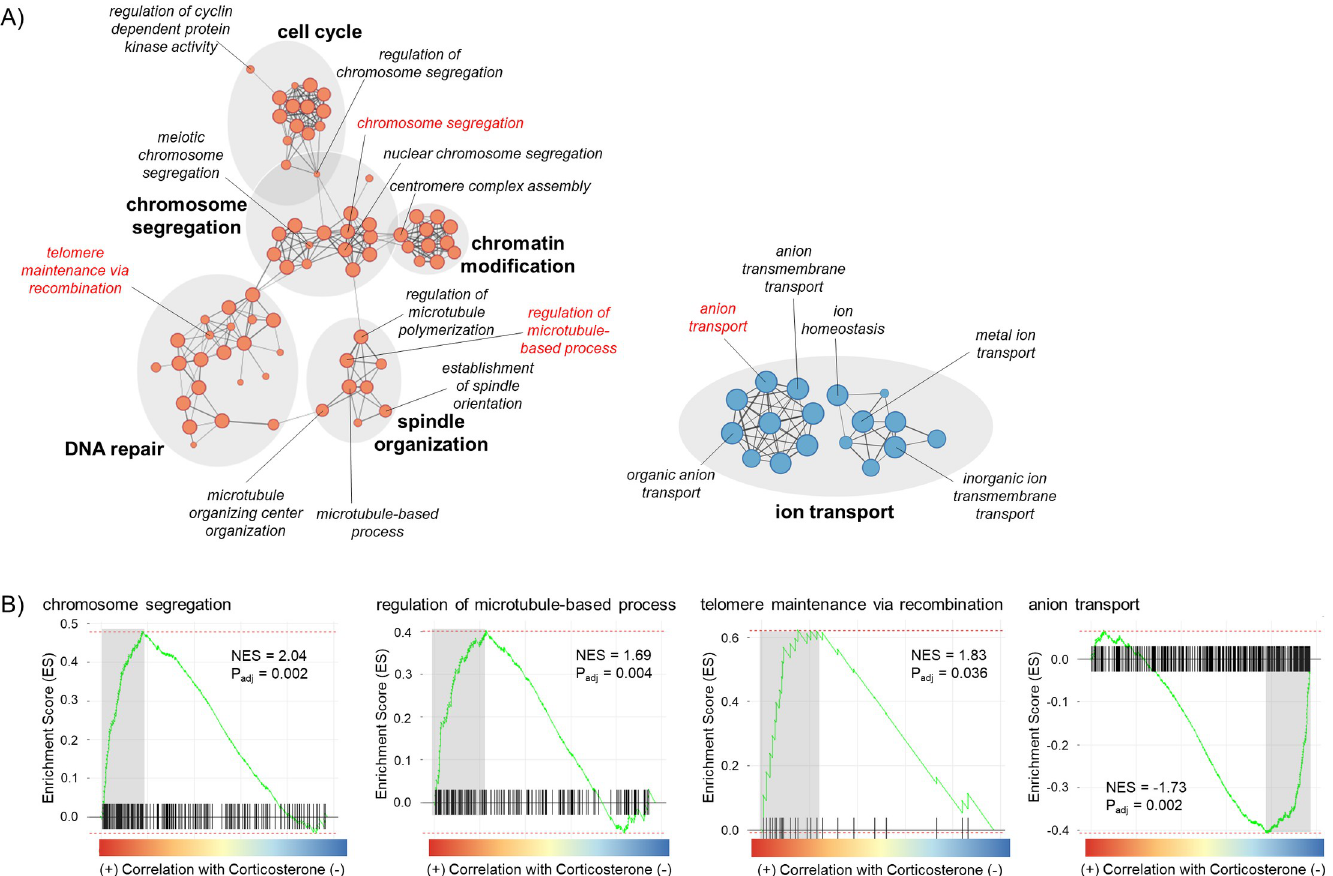
Fig 4. (A) Enrichment Map showing functional groups (shaded in gray) of gene sets detected in a Gene Set Enrichment Analysis (GSEA) comparing corticosterone- versus control-treated hens; select gene sets are highlighted in red. Only functional groups containing � 5 gene sets with p adj < 0.05 are included. Node size corresponds to gene set size and color designates the direction the gene sets were altered (red = enriched in corticosterone-treatment, blue = depleted in corticosterone- treatment). Line thickness connecting the gene set nodes represents the degree of gene overlap between the two sets. (B) GSEA enrichment plot for select gene sets. Black bars represent the position of members of the gene set in the ranked list together with the running enrichment score (ES; plotted in green). The adjusted p-value and normalized enrichment score (NES) are presented. Leading edge genes (i.e., those that contribute most to the ES) are highlighted in gray can be found in S2 Table.